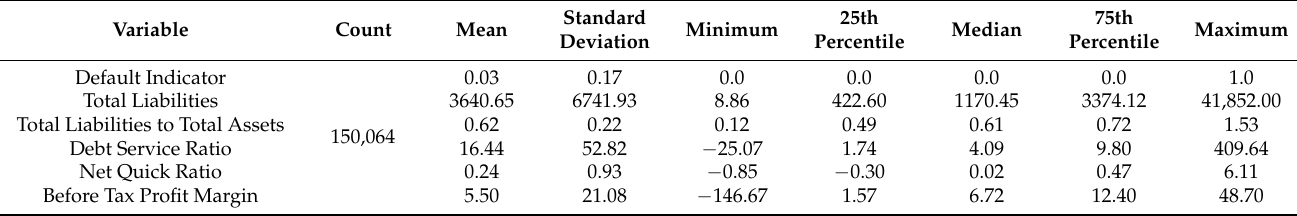
Table 5. Summary Statistics—Moody’s Large Corporate Financial and Explanatory Variables and Default Indicators: 3-Year TTC Model 1.